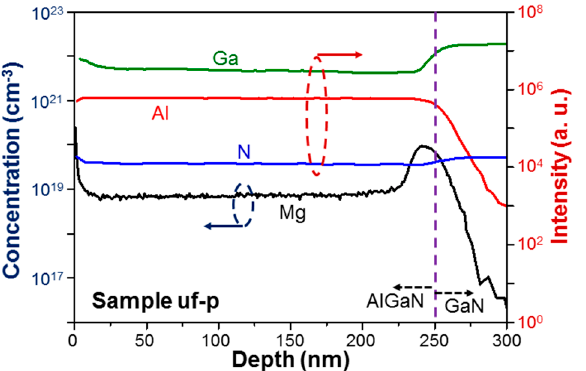
Figure 7. Secondary ion mass spectroscopy (SIMS) measurement results of sample uf-p with the left ordinate for the absolute Mg concentration and the right ordinate for the relative concentrations of Ga, Al, and N.